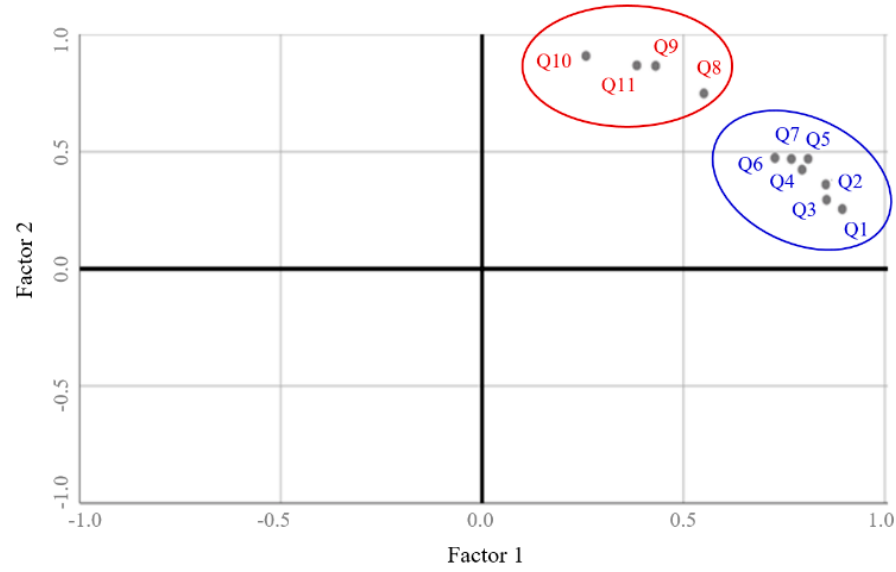
Figure 1. Principal component analysis (PCA) of the mCFQ11 structure. PCA was conducted for two-Figure 1. Q1 to Q7) and mental fatigue (factor 2, Q8 to Q11) based on covariance for a scale reliability of 11